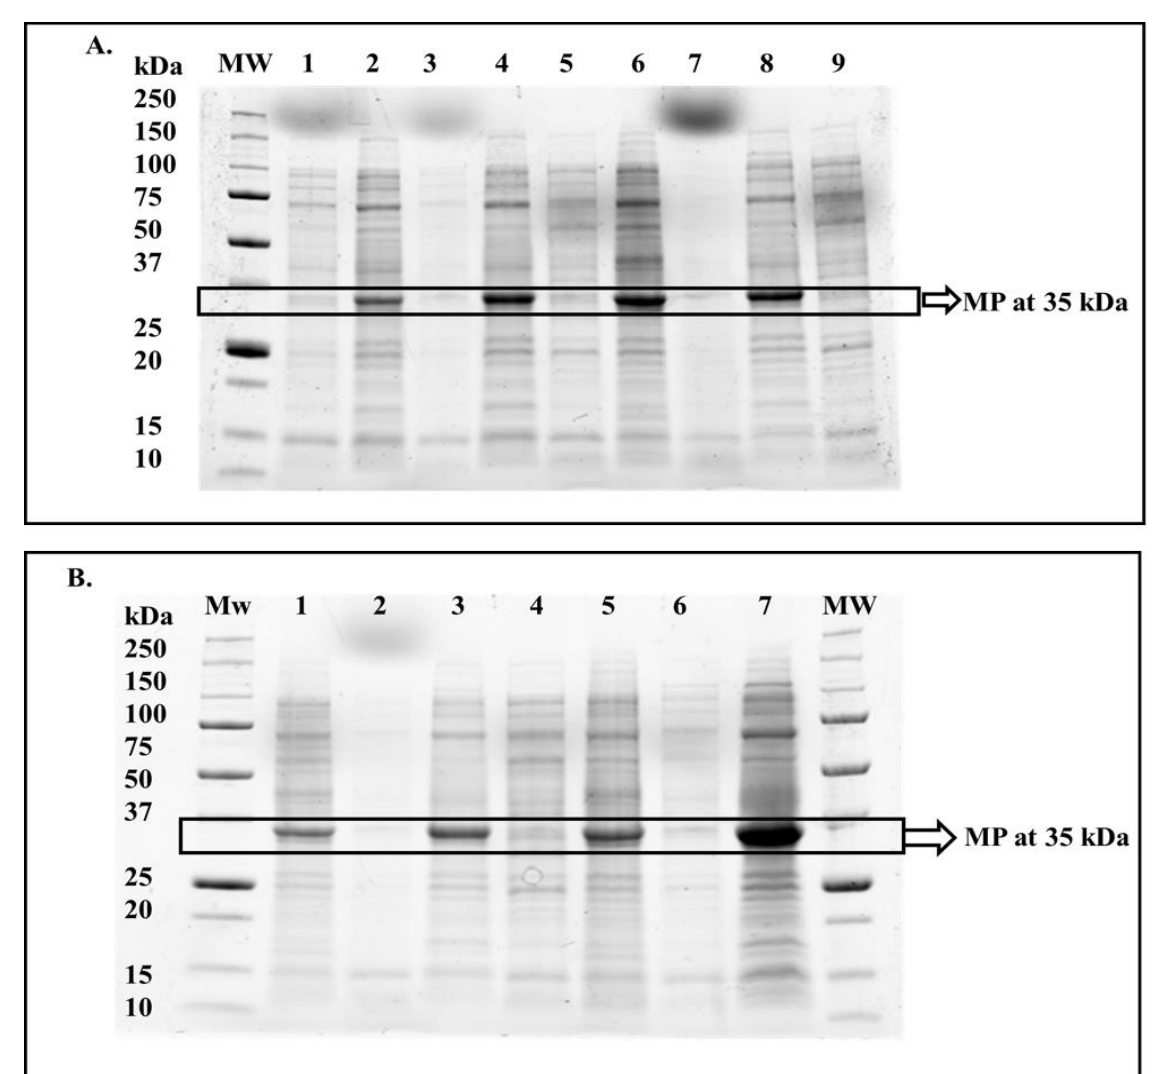
Figure 1. SDS – PAGE gels (12%) showing expression of SACMV MP (35 kDa including the His tag) in non-induced and induced (0.25 mM IPTG at 37 °C) fractions for 1 – 2 h ( A ) and 3 – 4 h ( B ) ( A ) Mw: molecular weight marker (Bio-Rad unstained ladder); Lanes 1: soluble, non-induced, 1 h; 2: soluble, induced, 1 h; 3: insoluble, non-induced, 1 h; 4: insoluble, induced, 1 h; 5: soluble, non-induced, 2 h; 6: soluble, induced, 2 h; 7: insoluble, non-induced, 2 h; 8: insoluble, induced, 2 h; 9: soluble, non-induced, 3 h. ( B ) Mw: molecular weight marker; Lanes 1: soluble, induced, 3 h; 2: insoluble, non-induced, 3 h; 3: insoluble, induced, 3 h; 4: soluble, non-induced, 4 h; 5: soluble, induced, 4 h; 6: insoluble, non-induced, 4 h; 7: insoluble, induced, 4 h.